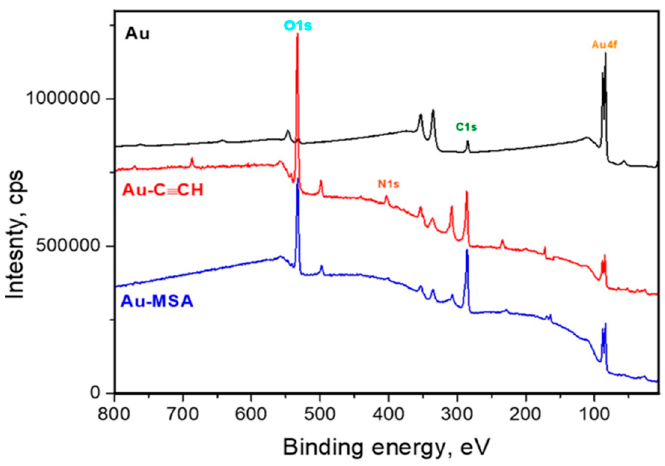
Figure 3. XPS survey spectra from gold gratings grafted with mercaptosuccinic acid via thiol–yne reaction under simulated sunlight irradiation.